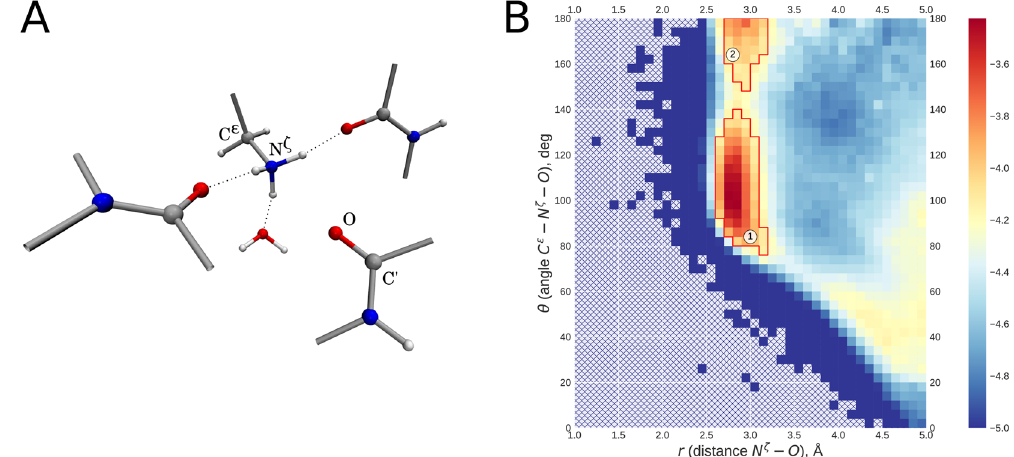
Figure 1. ( A ) Example of the lysine NH 3 + – carbonyl linear arrangement as extracted from the crystal structure PDB ID 4RLZ 45 (resolution 1.19 Å, R free = 0.160). NH 3 + group additionally forms hydrogen bonds to two other carbonyl sites and crystallographic water (shown by dashed lines). ( B ) Map illustrating relative positioning of the lysine NH 3 + and proximal carbonyl groups based on comprehensive analysis of high- and medium- resolution x-ray structures in the Protein Data Bank. Shown in the map is the phase-space density ρ ( r , θ ), i.e. the number of lysine/carbonyl pairs that fall in a given square (pixel) divided by the total number of such pairs in the map and further divided by the volume of space corresponding to this pixel, π θ θ Ω = ∆ ∆ r r 2 sin 2 . Note that the volume Ω is related to configurational entropy, = Ω S R ln , and therefore ρ ( r , θ ) reflects the enthalpy part of the free energy (as it should be for canonical ensemble in condensed phase) 46 . Color scale is logarithmic as indicated in the color bar on the side. Red contours around clusters 1 and 2 are drawn with the boundary ρ = − . log 4 14 . Shown in Fig. S1 are the analogues of this map using a more stringent selection of PDB structures limited to ( i ) very high resolution x-ray structures and/or ( ii ) unique structures excluding identical or highly similar